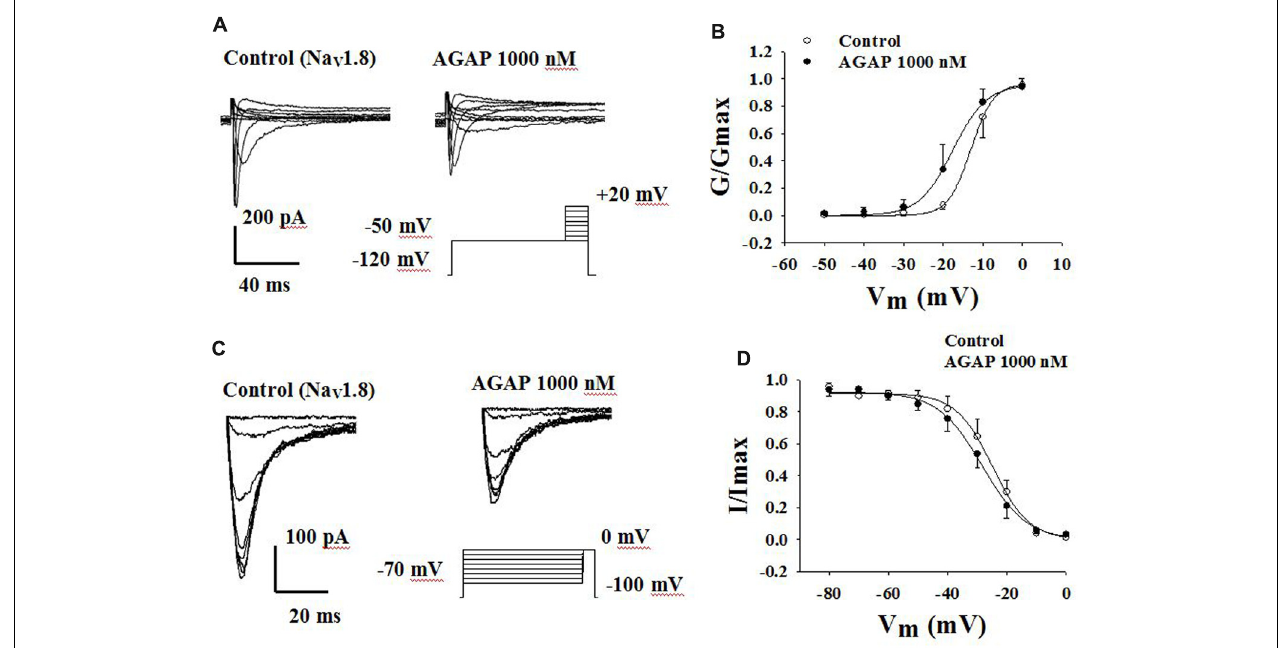
FIGURE 8 | Effect of AGAP on the dynamic function of Na V 1.8 channels. (A,B) AGAP shifts the conductance-voltage relationship to more negative potentials. (A) Representative steady-state activation of Na V 1.8 under the control conditions and in the presence of 1000 nM AGAP. (B) Normalized activation kinetics determined before and after the application of AGAP. V 1 / 2 was − 13.0 ± 0.2 mV in control conditions and − 17.6 ± 0.4 mV in the presence of 1000 nM AGAP ( P < 0.05, n = 5). Slope factors were 2.8 ± 0.1 and 4.2 ± 0.3 mV, respectively ( P < 0.05, n = 5). P values are from unpaired t -test. (C,D) AGAP had no effect on the voltage-dependence of steady-state inactivation. (C) Representative steady-state inactivation of Na V 1.8 under the control conditions and in the presence of 1000 nM AGAP. (D) Normalized peak currents were plotted against membrane potential and Boltzmann equation was used to fit data. V 1 / 2 was − 25.0 ± 0.3 mV in control conditions and − 25.4 ± 0.6 mV in the presence of 1000 nM AGAP. Slope factors were − 5.5 ± 0.3 and − 6.0 ± 0.5 mV, respectively ( P > 0.05, P values are from unpaired t -test. n =